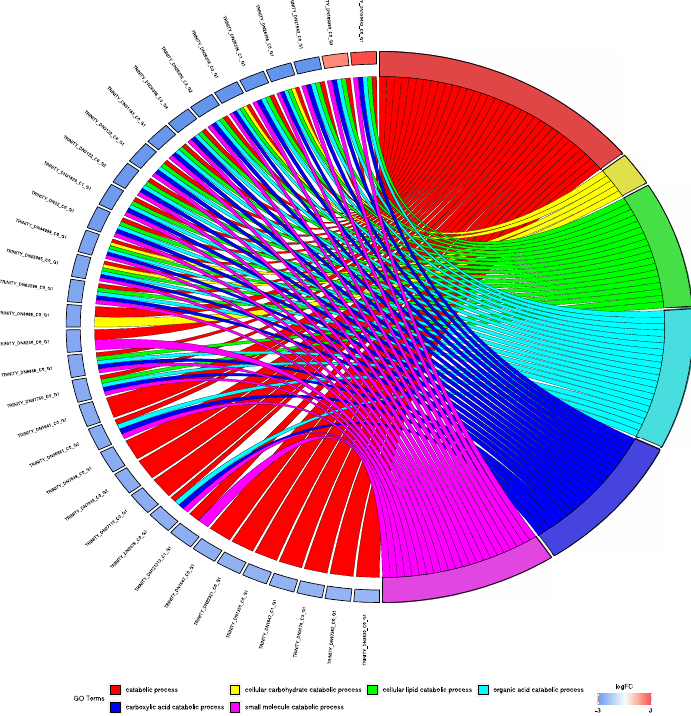
Figure 2. Circos plot obtained from functional enrichment analysis performed on differentially expressed genes derived from the comparison S vs.